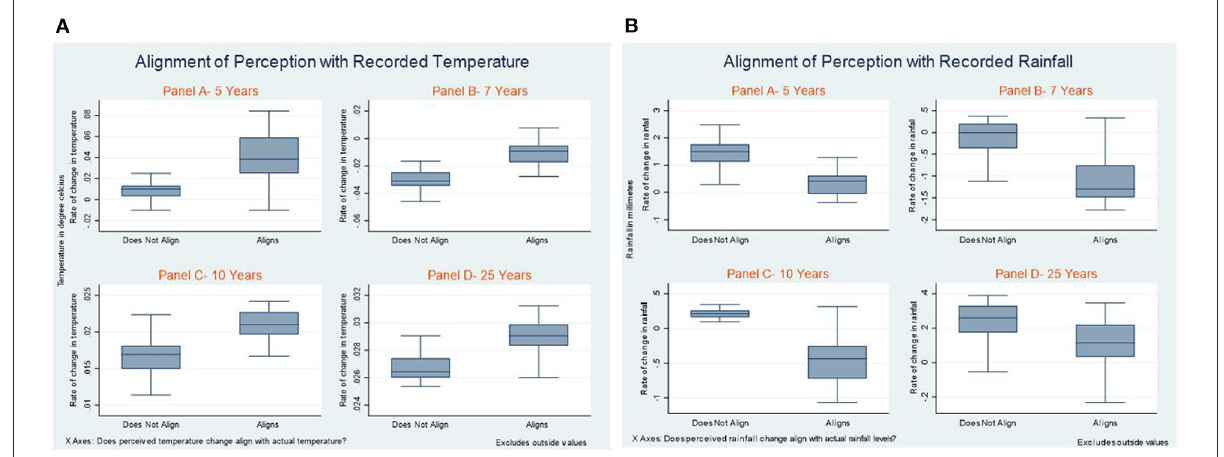
TABLE 3A Results of two-sample t -tests with unequal variances—Temperature. Group n Mean annual rate 5-year slope Not align